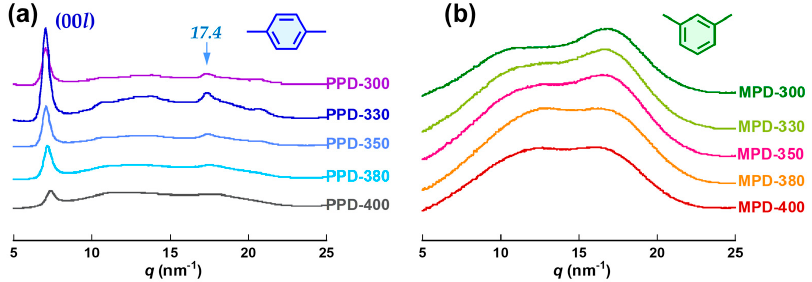
Figure 6. Wide-angle X-ray scattering (WAXS) patterns of the PI films derived from ( a ) PPD and ( b ) MPD.